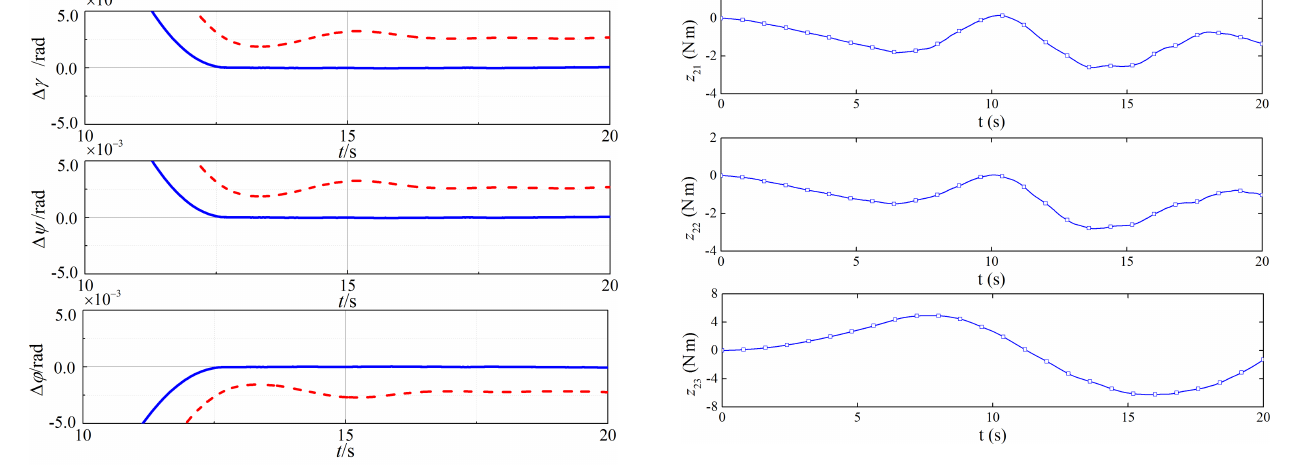
Figure 10. Estimated